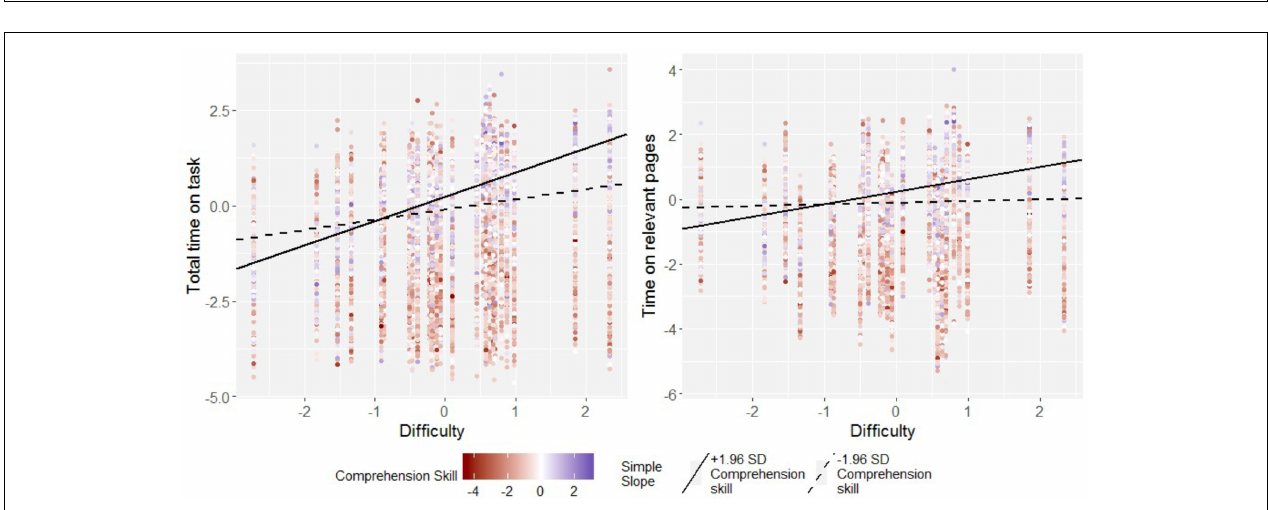
FIGURE 4 | Simple slopes for the regression of total time on task and time on relevant pages on task difficulty in students high (97.5th perc.) and low (2.5th perc.) in comprehension skill for one sample country (Australia). Data points are raw data. Regression intercepts and slopes are model-based